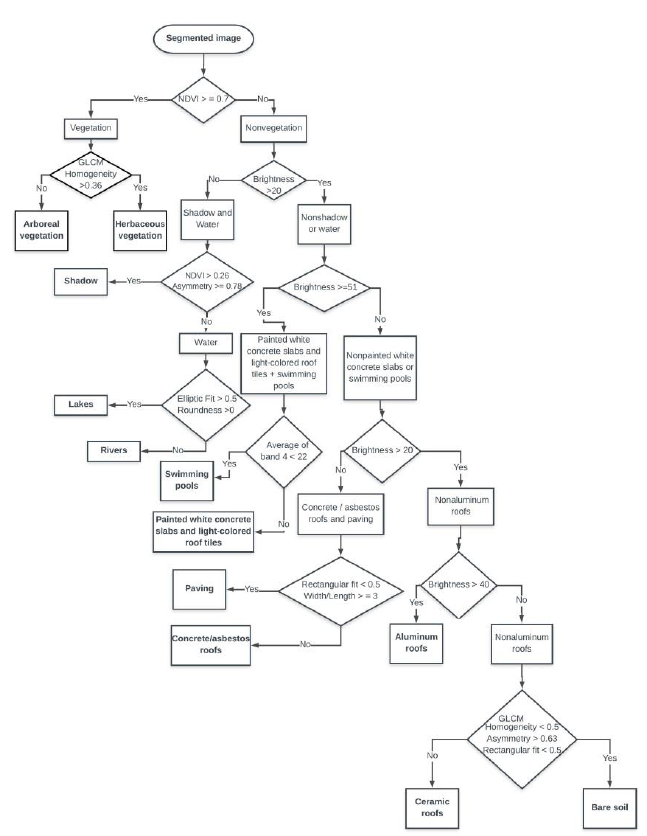
Figure 4. Classification rule decision tree in the e-Cognition software.